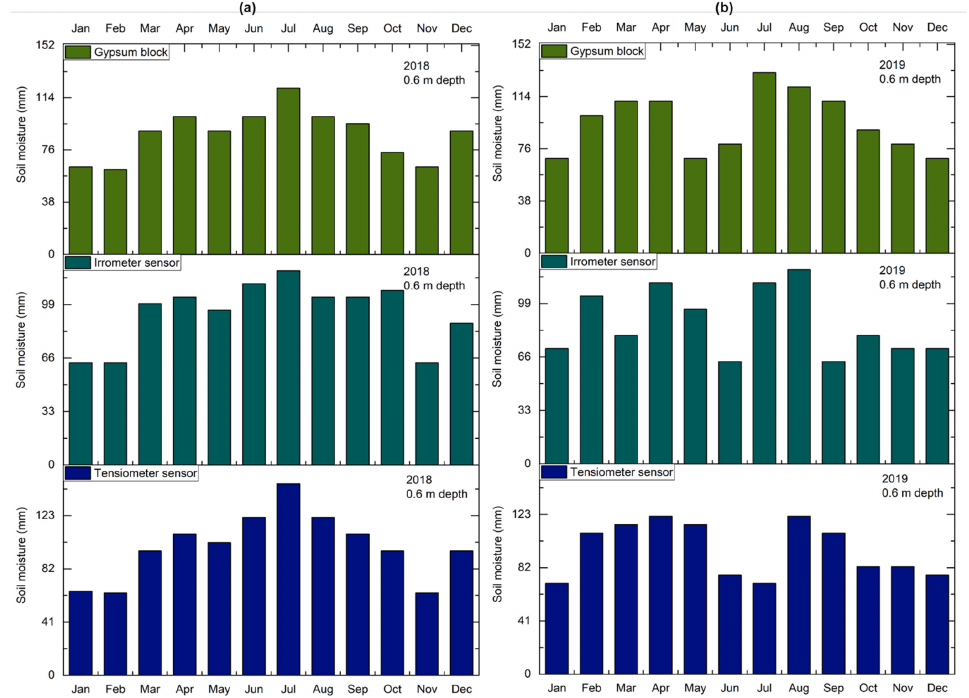
Figure 10. Timeline graphs of soil moisture distribution profiles used to schedule irrigation in ( a ) 2018 at 0.6 m depth and ( b ) 2019 at 0.6 m depth by different soil moisture sensors. By applying the optimum amount of irrigation water at the right time and main- taining the optimum soil moisture level in the field one can increase olive yield. Figure 11 shows a comparison of olive yield (kg/ha) and yield efficiency (%) using different soil moisture sensors as compared to conventional farmer practice in 2018 and 2019. An in- crease in yield efficiency of 6% to 9% was observed using soil moisture sensors as com- pared to conventional farmer practice. However, less yield was observed in 2019 be- cause of the alternate bearing nature of the olive variety. The results of an increase in yield by the soil moisture sensors showed close agreement with results of a similar study reported in the literature [40]. The irrigation frequency was decided from two perspec- tives: when there was less moisture in 0.3 m depth and high moisture in 0.6 m depth, the irrigation cycle was slow so that it could irrigate only the upper 0.3 m of the soil while the moisture at 0.6m depth was irrigated less; by contrast, a longer cycle of irrigation was needed to irrigate the deep layer of the soil. The soil moisture sensors discussed in this study are efficient, reliable, low-cost and farmer friendly.